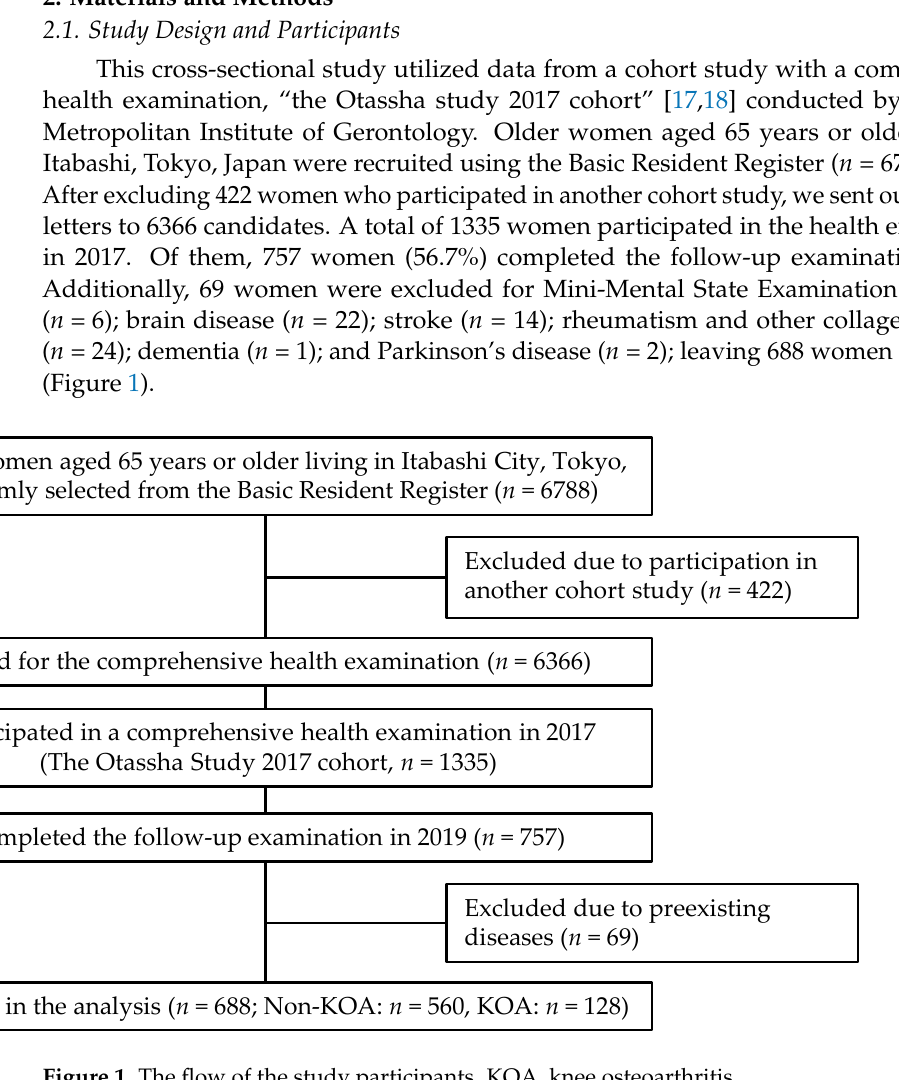
Figure 1. The flow of the study participants. KOA, knee osteoarthritis.